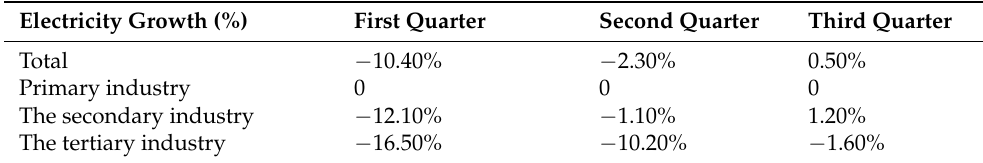
Table 3. Electricity growth changes in the first three quarters of 2020 in China.